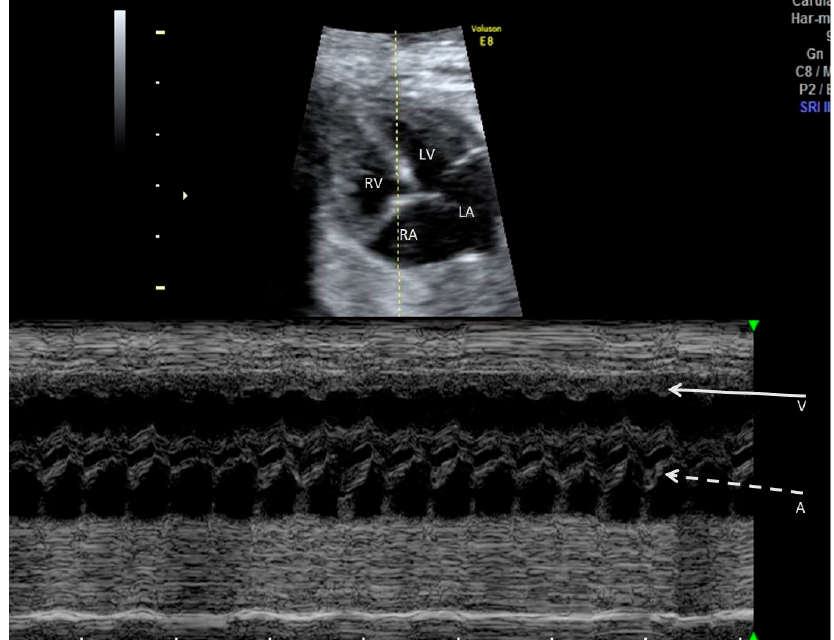
Figure 1. M-mode, linear representation of adjacent cardiac structures motion as a function of time. A 2D relevant image of the fetal heart is first obtained; then, the M-mode cursor is placed at the targeted location on that image. In case of arrhythmia, the M-mode cursor is usually placed across an atrium and a ventricle, so that the relationship of atrial to ventricular contractions is recorded. Arrows indicate ventricular (V) and atrial (A) contractions.